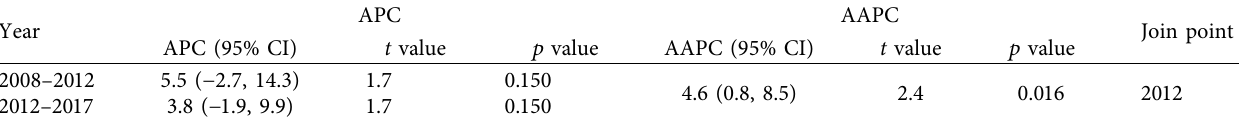
Abbreviations: ASR, age-standardized mortality Table 6: APC and AAPC of crude mortality of female breast cancer in urban Shenyang in 2008–2017.